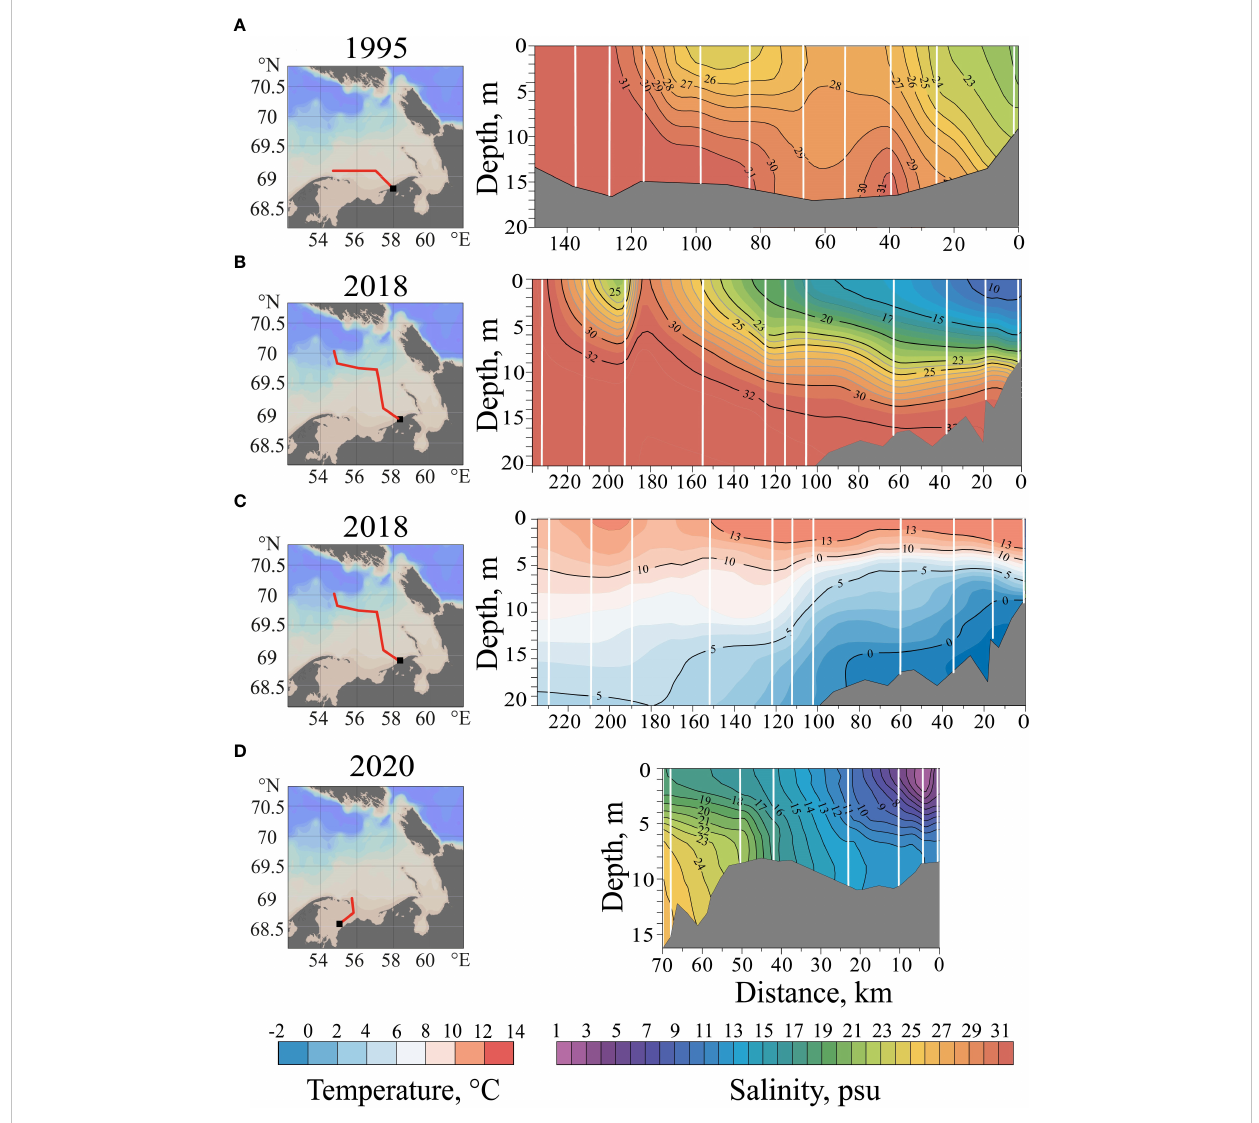
FIGURE 6 The vertical salinity structure along the Varandey shore on 9-17 July 1995 (A) , in the central part of the Pechora Sea on 18-23 July 2018 (B) , in the Pechora Bay on 16-19 July 2020 (D) . The vertical temperature structure in the central part of the Pechora Sea on 18-23 July 2018 (C) . Black squares at the left insets shows location of beginning point of the sections. The bathymetric data in 1995 were taken from the International Bathymetric Chart of the Arctic Ocean (IBCAO) (Jakobsson et al., 2012); the bathymetric data in 2018 and 2020 were taken from shipboard echo